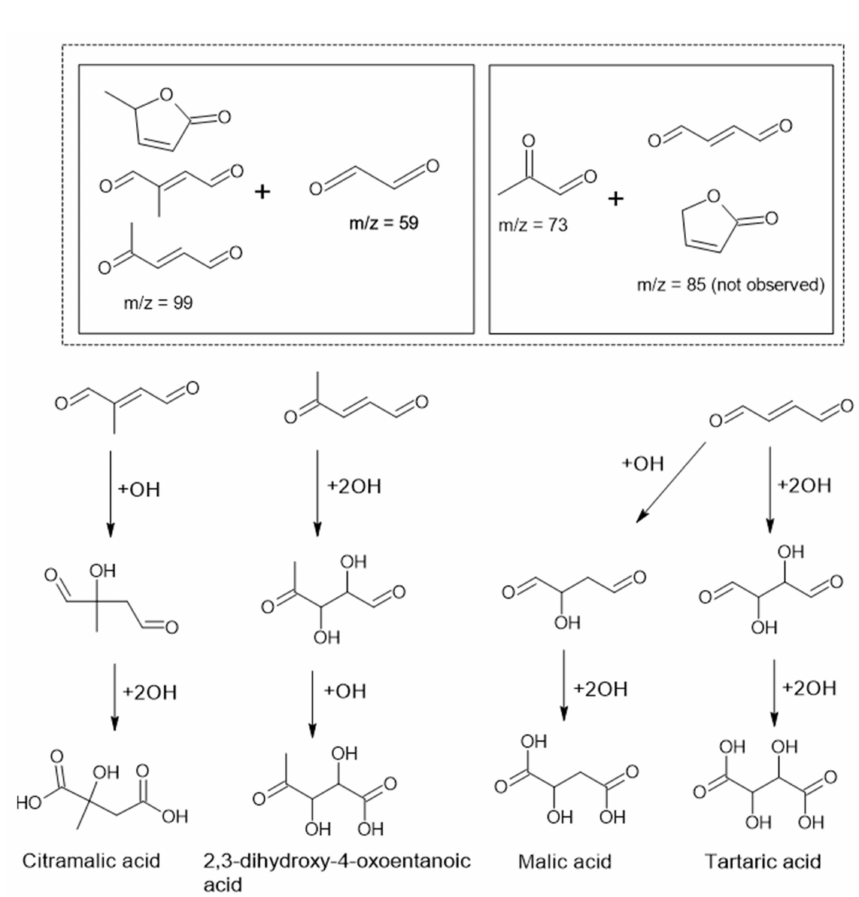
Figure 8. Proposed formation mechanism of particle phase products observed in the current study. C5 diacids, such as glutaric acid, 3-hydroxyglutaric acid, and 2,3-dihydroxyglutaric acid, have been identified in many SOA samples, including SOA collected from urban and rural areas [40,41,44,45], as well as from cyclohexene oxidation [46,47]. However, to the best of our knowledge, the identification of C5 diacids has not been reported in